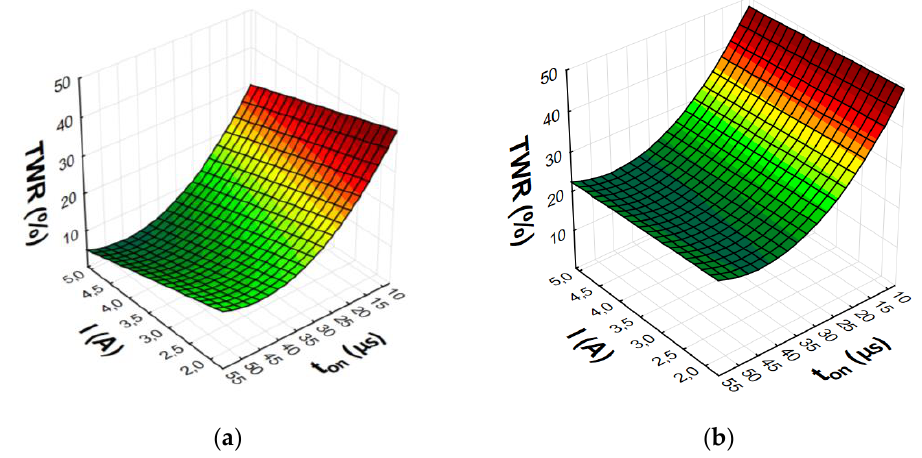
Figure 9. Graphical representation of regression equation for TWR of ( a ) AF-5 and ( b ) S-180.